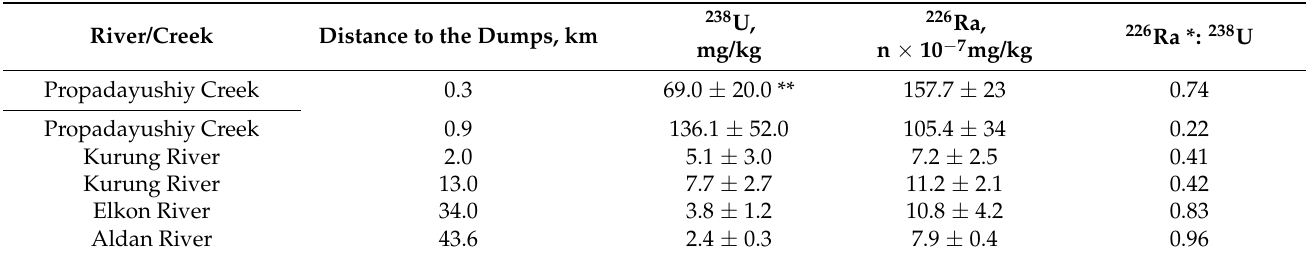
Table 7. Content of 238 U and 226 Ra in alluvial soils at different distances from the rock dumps of the Kurung site in Southern Yakutia.